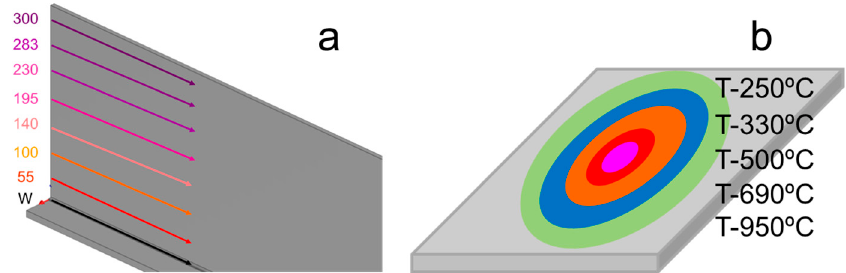
Figure 3. ( a ) Vertical parametrization in mm; ( b ) Temperature objective parametrization.